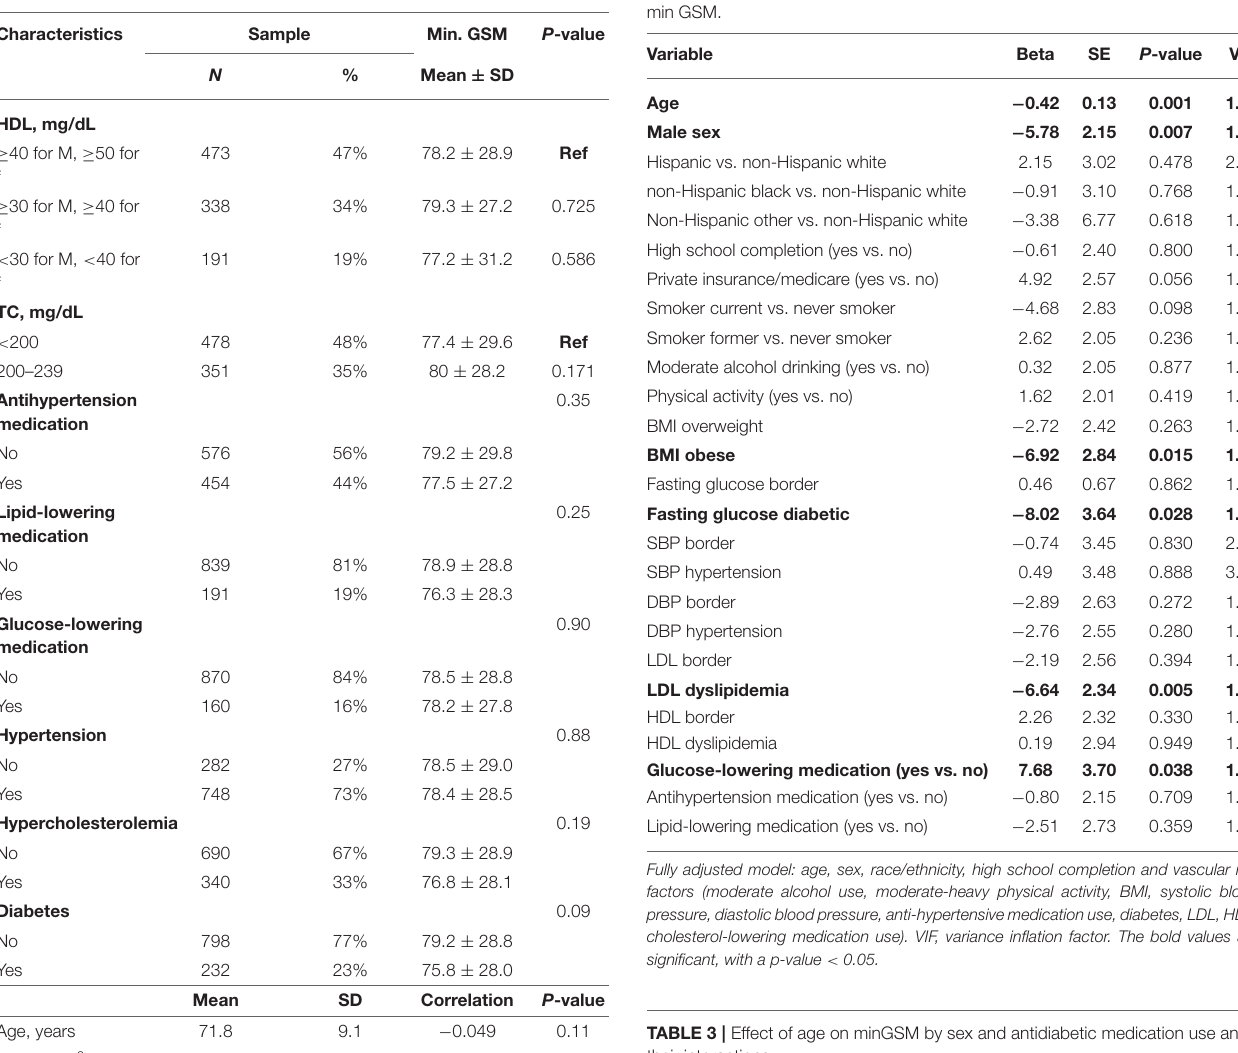
TABLE 3 | Effect of age on minGSM by sex and antidiabetic medication use and their interactions.